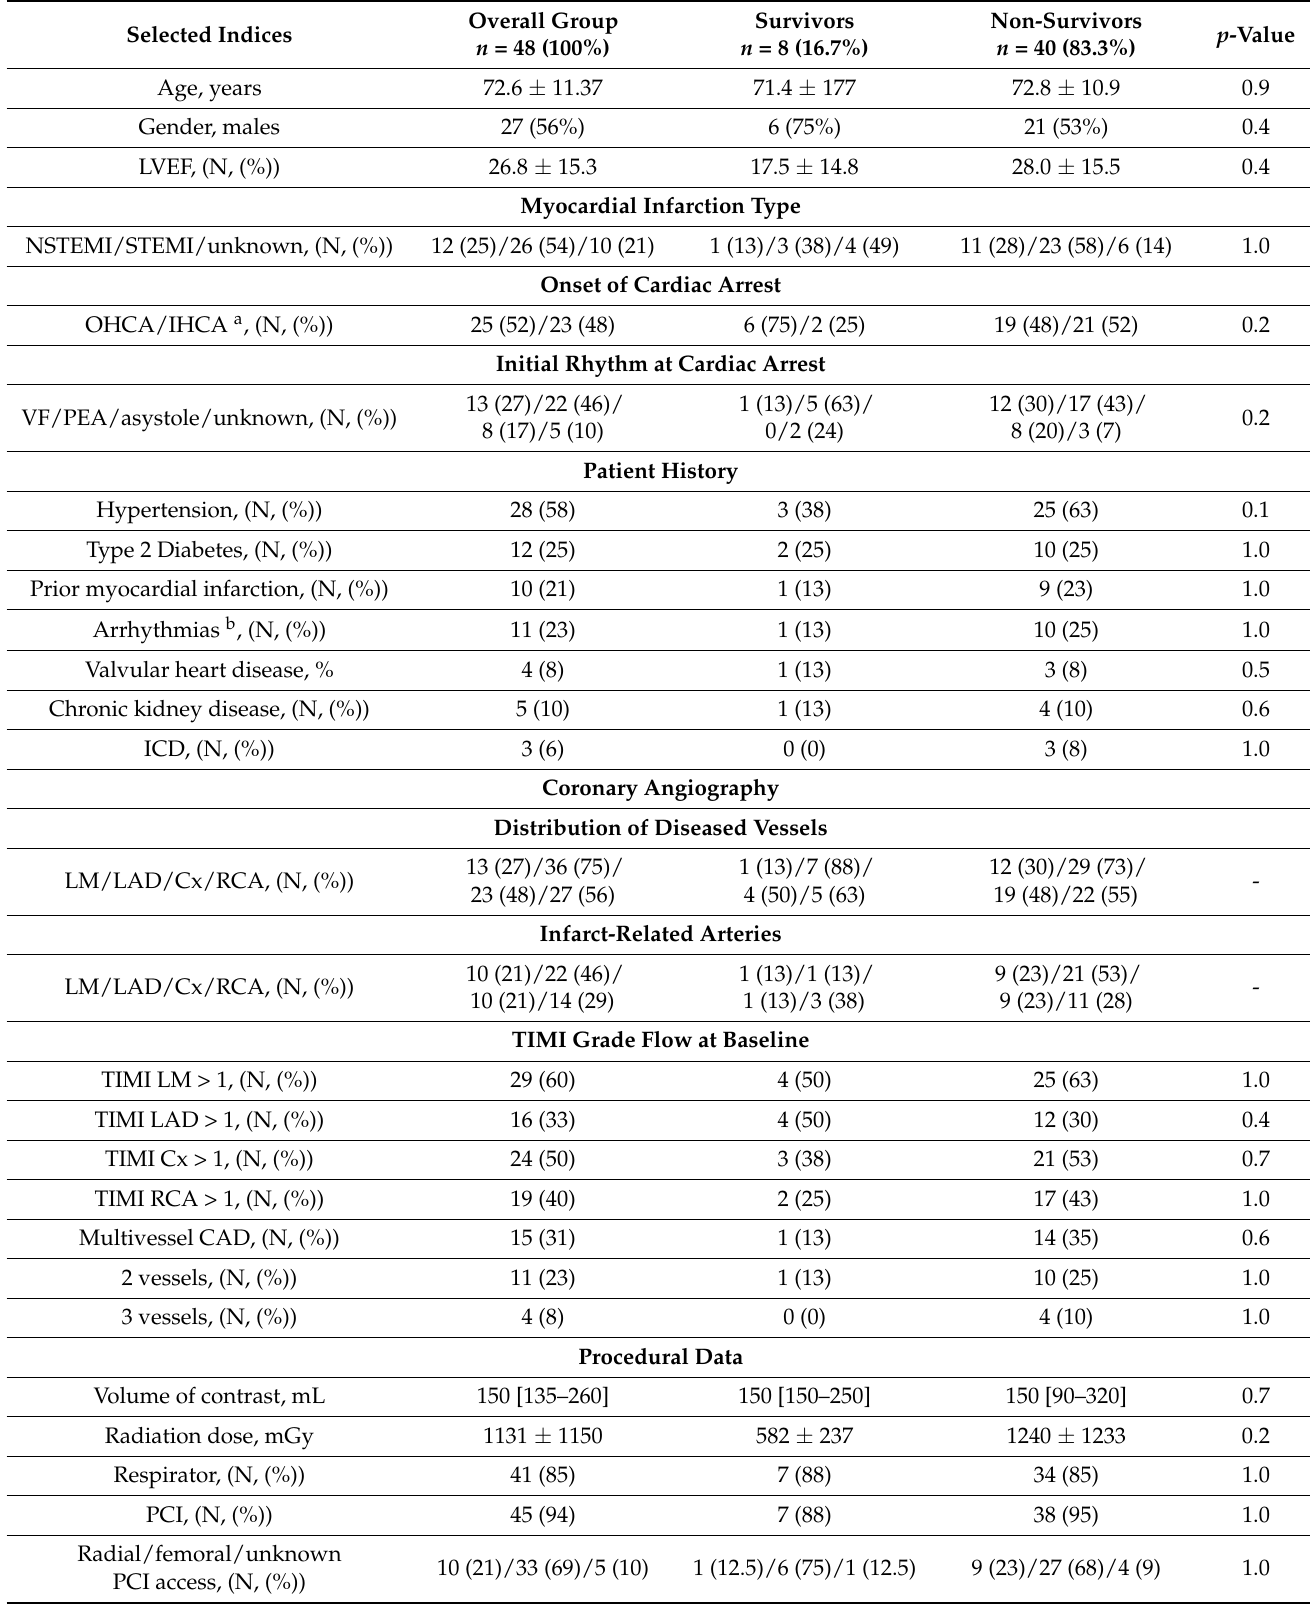
Table 1. Characteristics of patients and